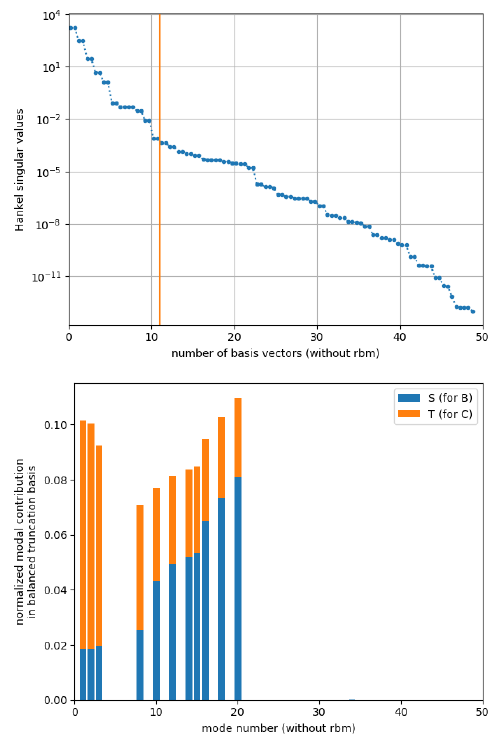
Figure 11. Mode selection by balanced truncation. Hankel singular values ( top figure) show the expected increase in accuracy for each added DOF. The bottom plot shows the selected modes: orange for observability and blue for controllability. (The rigid body mode was removed